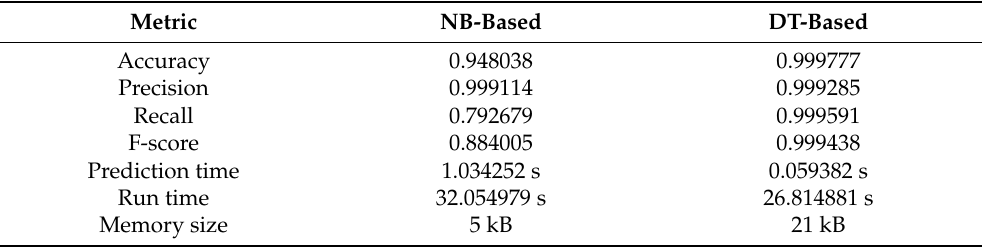
Table 3. NB-based and DT-based anomaly detectors’ metrics recorded (binary classification).